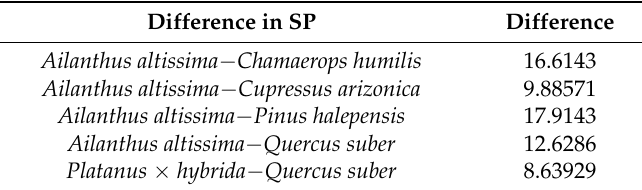
Table 10. Significant results to 95% of the multiple range test (LSD) for %W according to